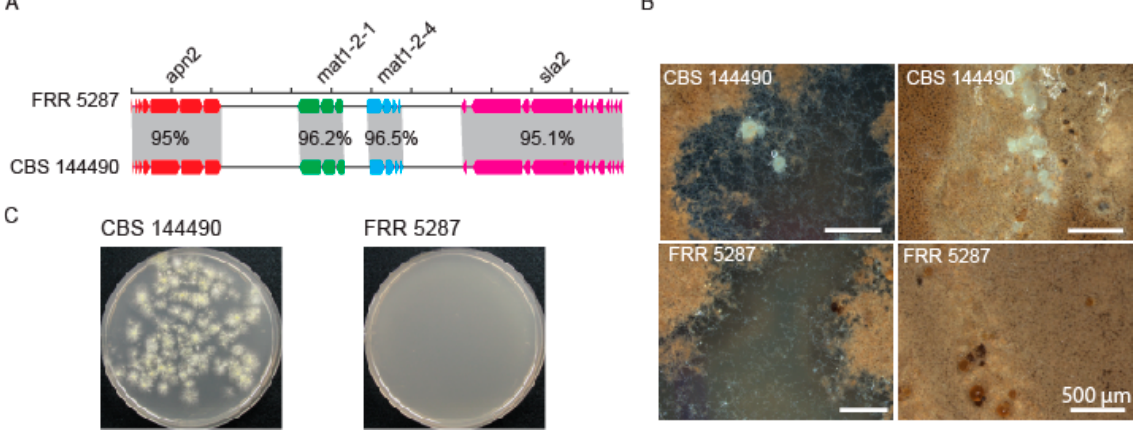
Figure 3. Strain FRR 5287 is reproductively isolated from P. variotii . ( A ) Diagram of mating type loci. ( B ) Ascomata production of mating plates. ( C ) Germination of ascospores following heat treatment of mating material; only the positive control yielded colonies.